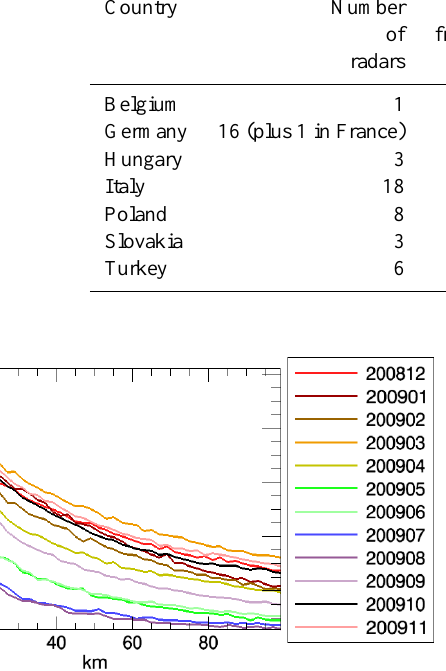
Fig. 2. Correlation coefficient between rain gauge pairs as a function of the distances between the rain gauges. Colours refer to the months of the year 2009.